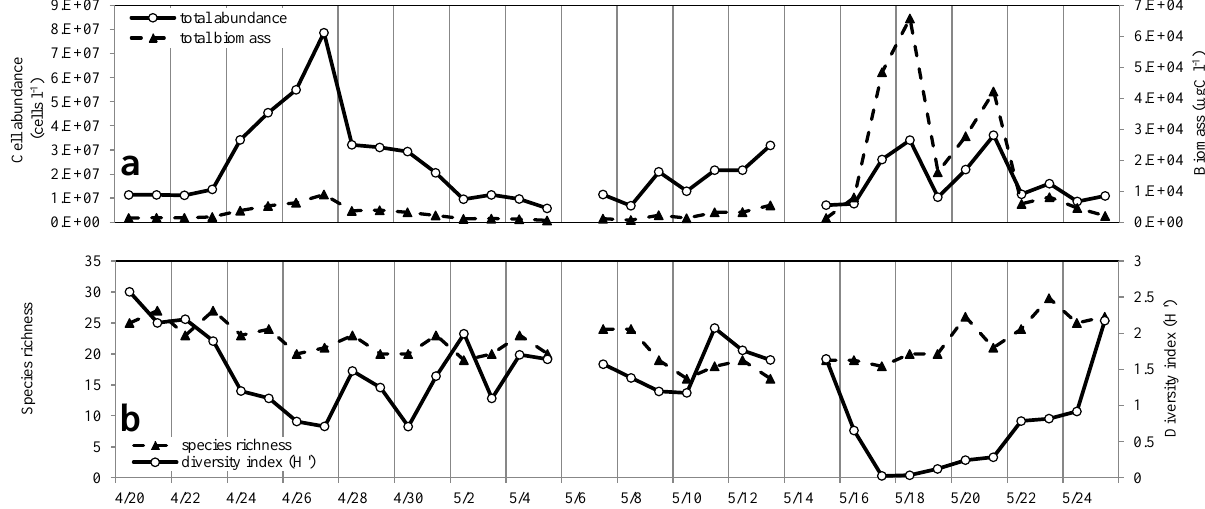
Figure 2. Nano and micro phytoplankton abundance and biomass ( a ), and phytoplankton diversity (Shannon diversity index H ′ ) and species richness ( b ) in daily samples collected from the Lafayette River between 20 April and 25 May 2006 .